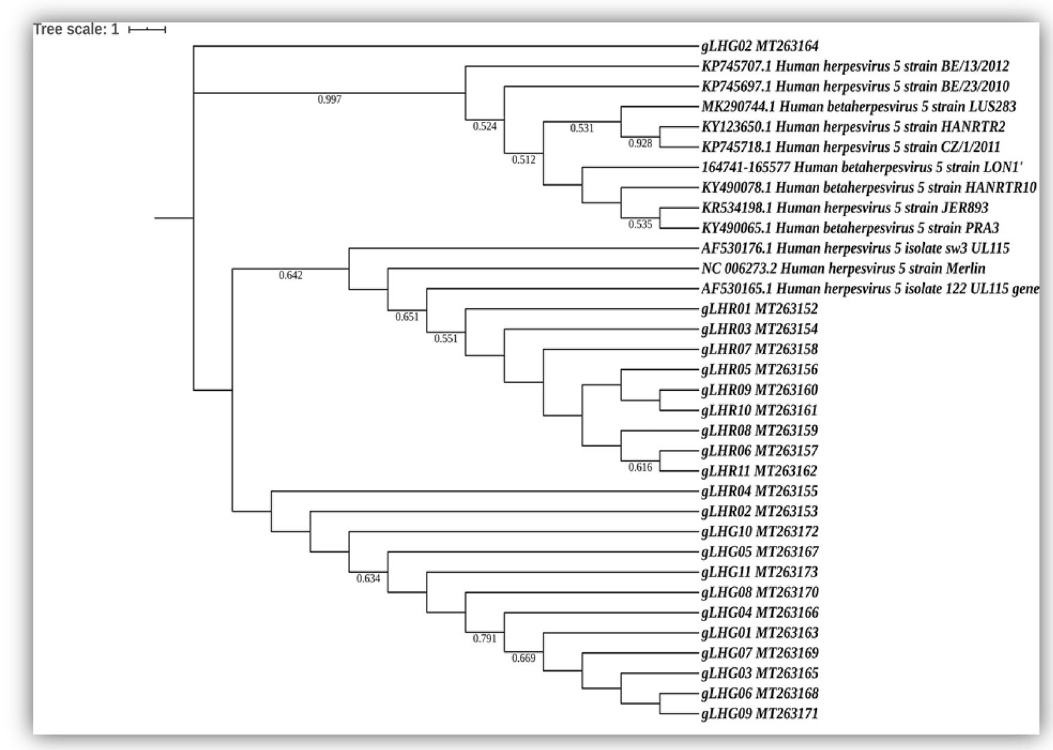
Figure 4. Phylogenetic analysis of the partially sequenced HCMV gL genes from 22 clinical samples belonging to group 1 (11 HR and 11 HG samples) along with 12 standard reference gL gene sequences selected from NCBI database.